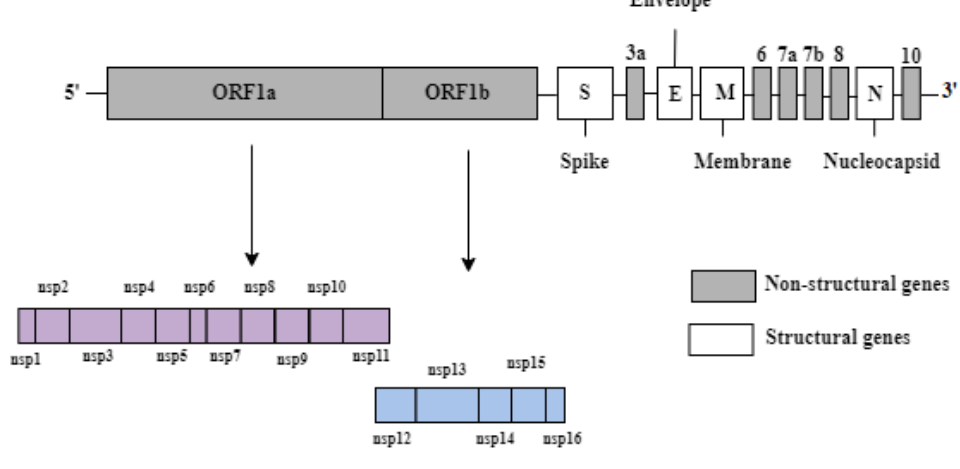
Figure 1. The genomic structure of